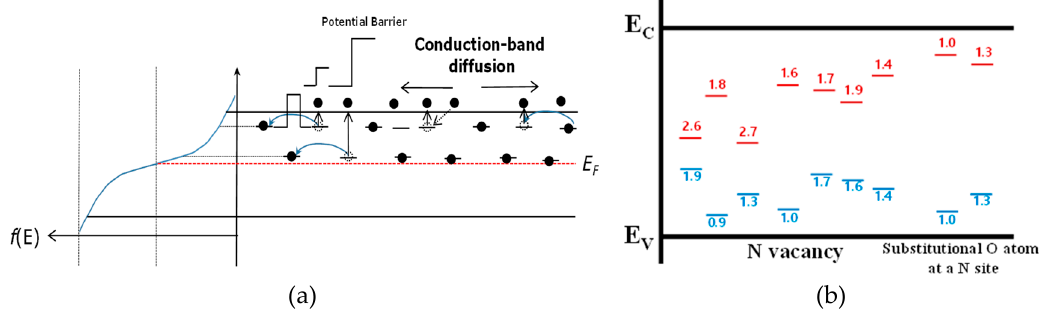
Figure 2. ( a ) Conduction mechanism of programmed Silicon-Oxide-Nitride-Oxide-Silicon (SONOS) memories, ( b ) energy level of silicon nitride.